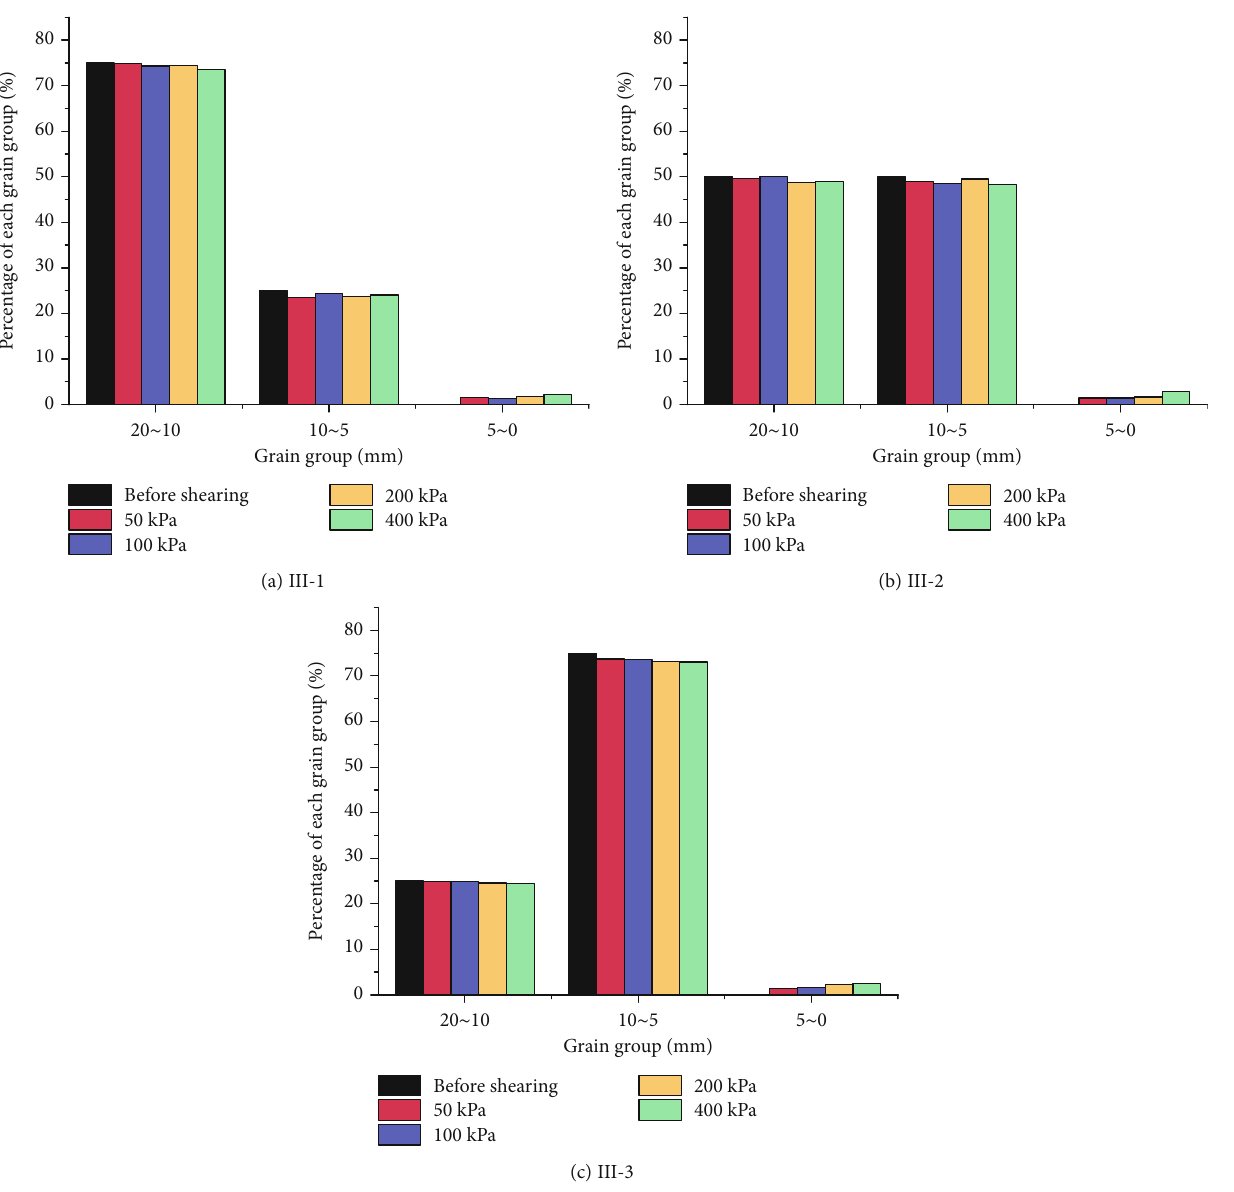
Figure 12: Histogram of contents of each grain group before and after shearing of group